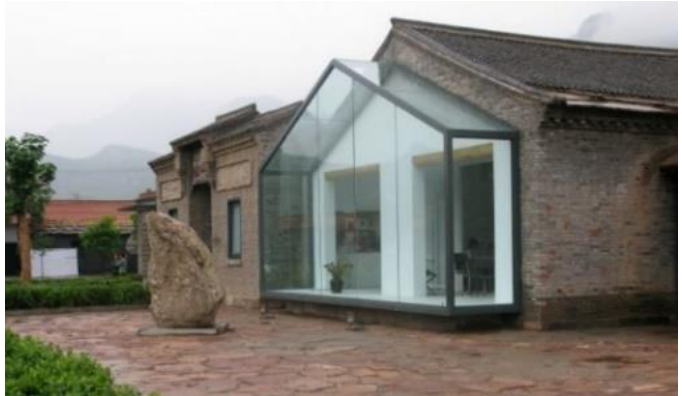
Figure 21. Reconstruction of Xucun Village in Shanxi Province (source: [49]).